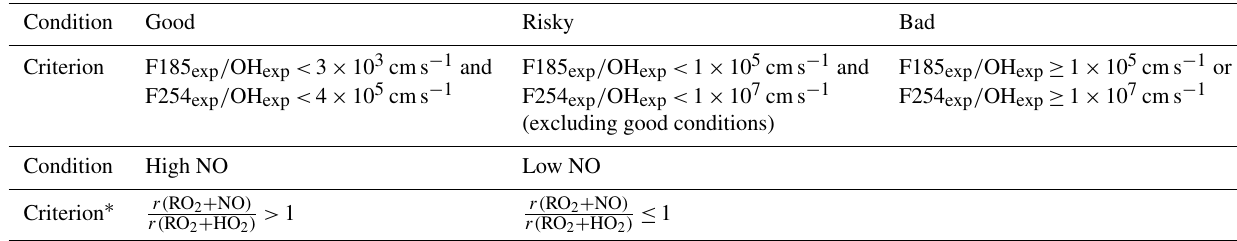
Table 3. Definition of condition types in this study (good/risky/bad high-/low-NO conditions). Condition Good Risky Bad